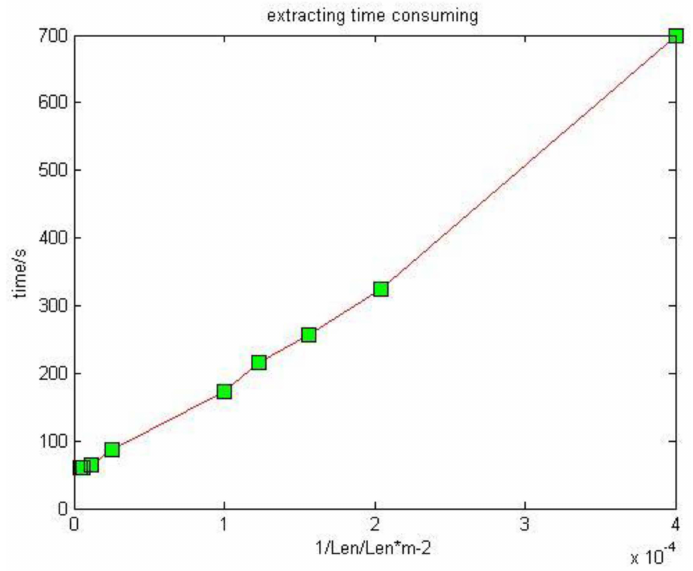
Figure 15. Plumb scanning implicit construction time with respect to the reciprocal of the quadratic of the grid length. The modeling time was nearly proportional to the reciprocal of the quadratic of the grid